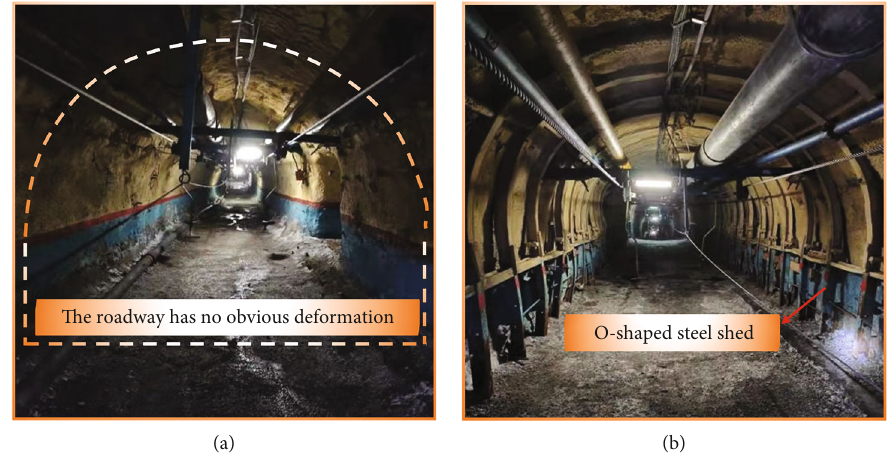
Figure 14: Field support e ff ect. (a) Reinforced support section. (b) Ordinary support